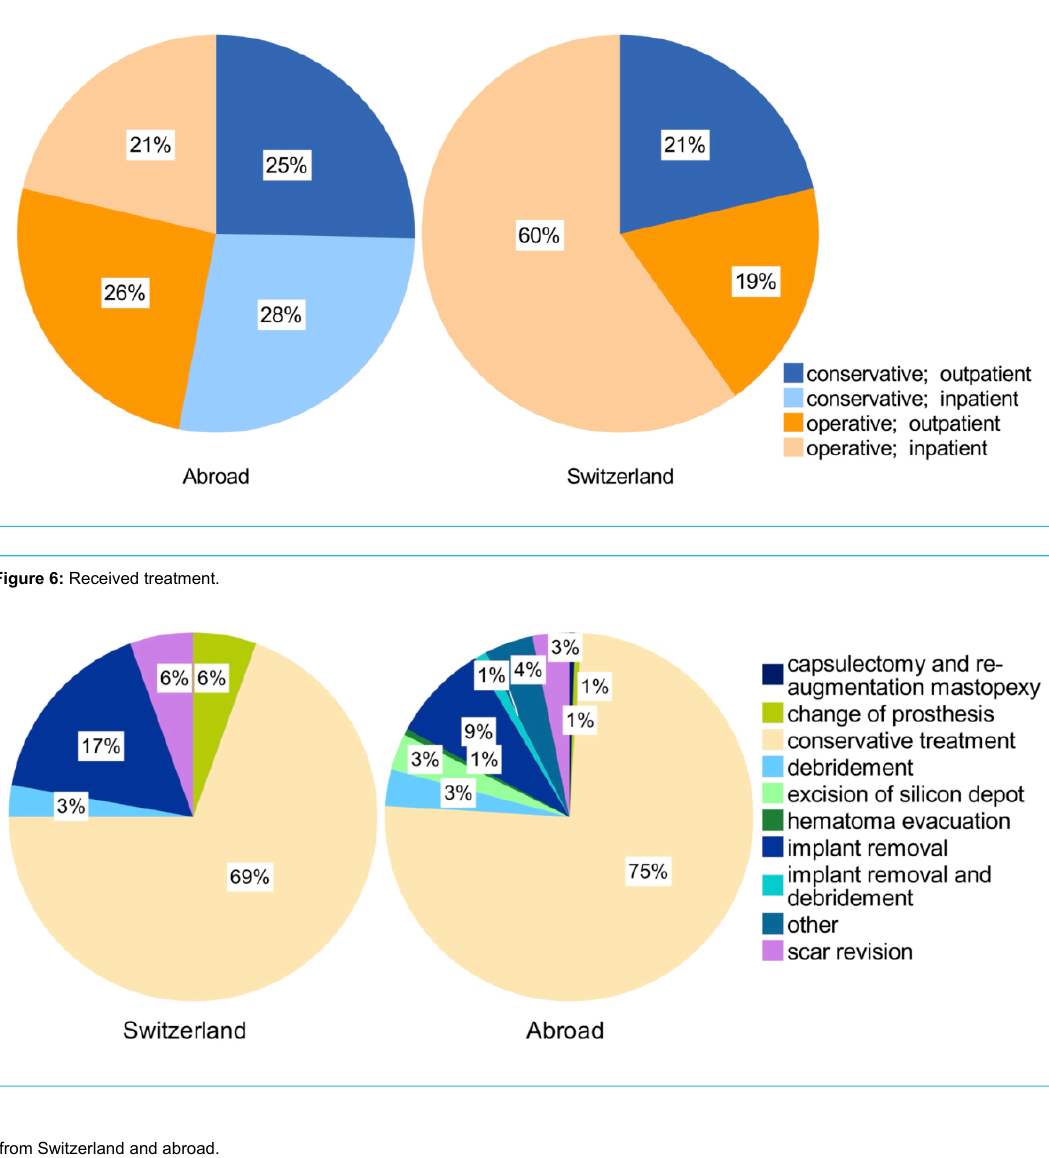
Figure 5: Percentage of received therapy according to treatment setting, excluding patients who presented only for consultation.